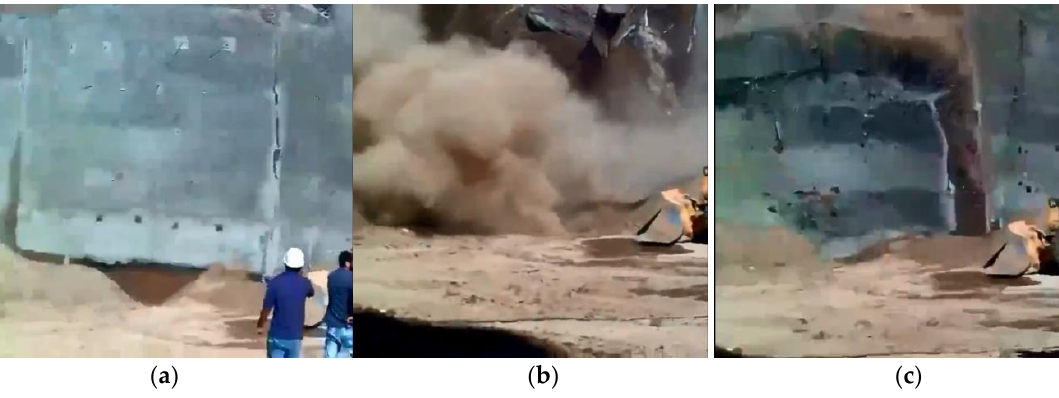
Figure 2. Collapse of a nail-restrained excavated wall in Tehran, Iran: ( a ) crack initiation on the wall, ( b ) start of the excavated wall collapse and ( c ) collapse of the vehicles and constructions on top of the excavated wall along with the wall into the excavated pit.